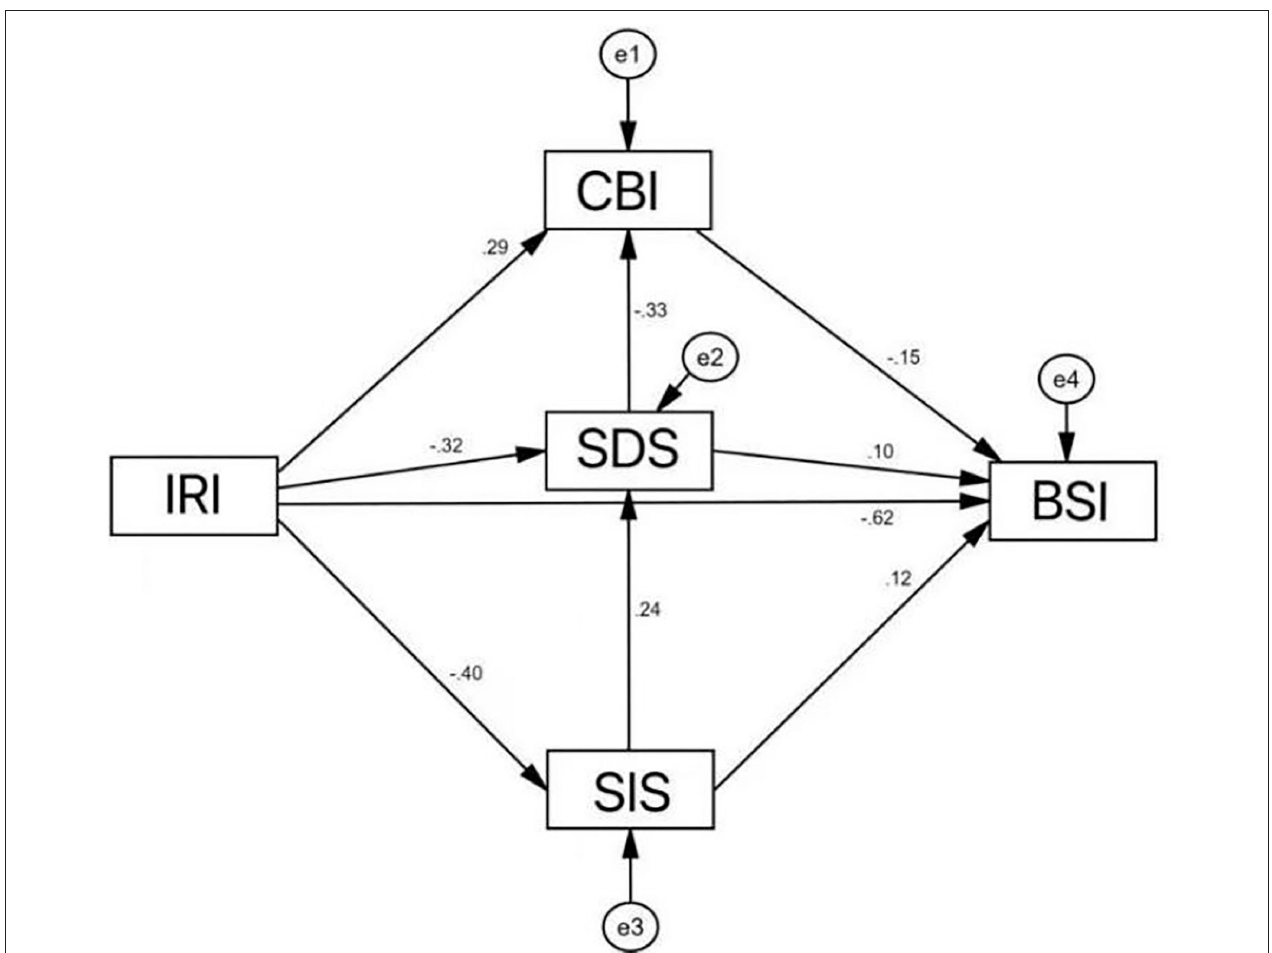
FIGURE 1 | The model of relationships among IRI, CBI, SDS, and BSI, with standardlized beta